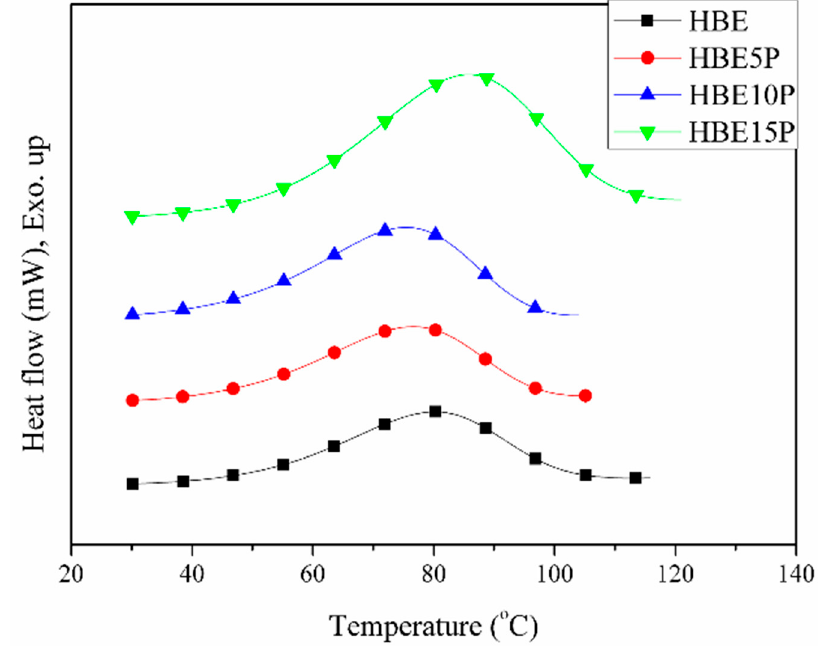
Figure 6. The curing behavior of HBE, HBE5P, HBE10P, and HBE15.